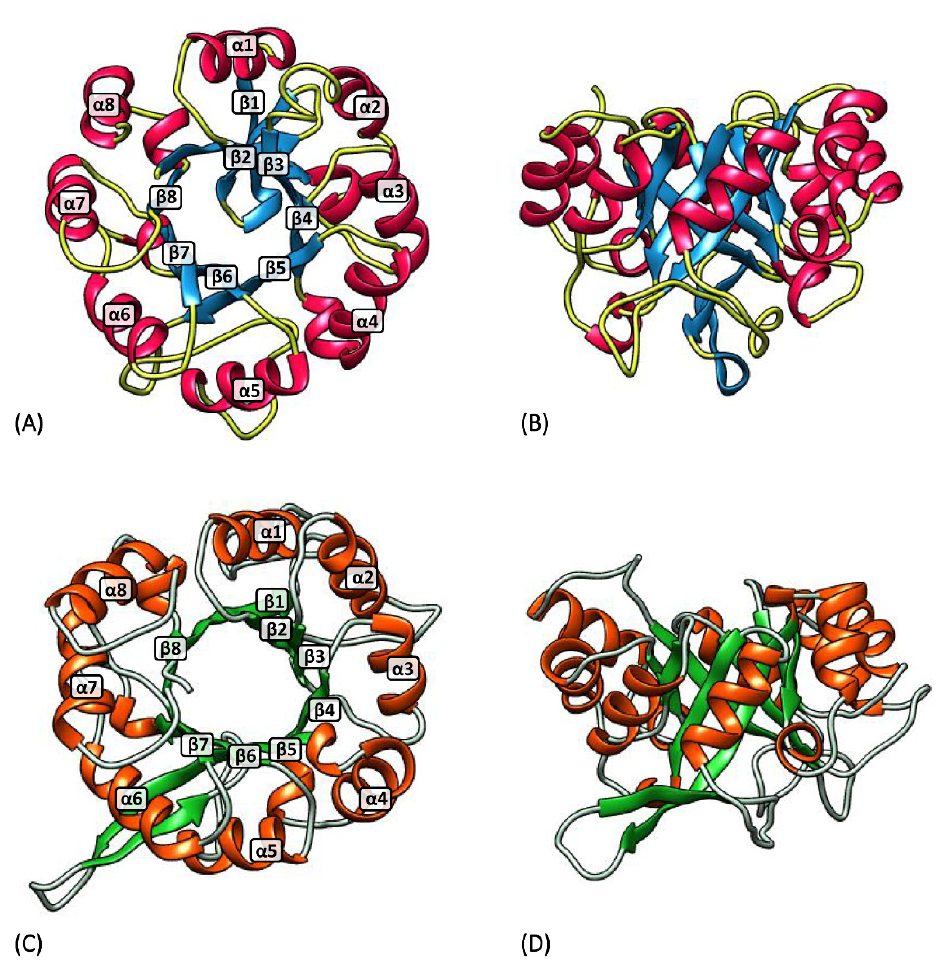
Figure 4. Three-dimensional structure of E. coli HisA ( A , B ) and HisF ( C , D ). ( A , C ) top view of the barrels; ( B , D ) side view. α -helices and β -strands are labeled.